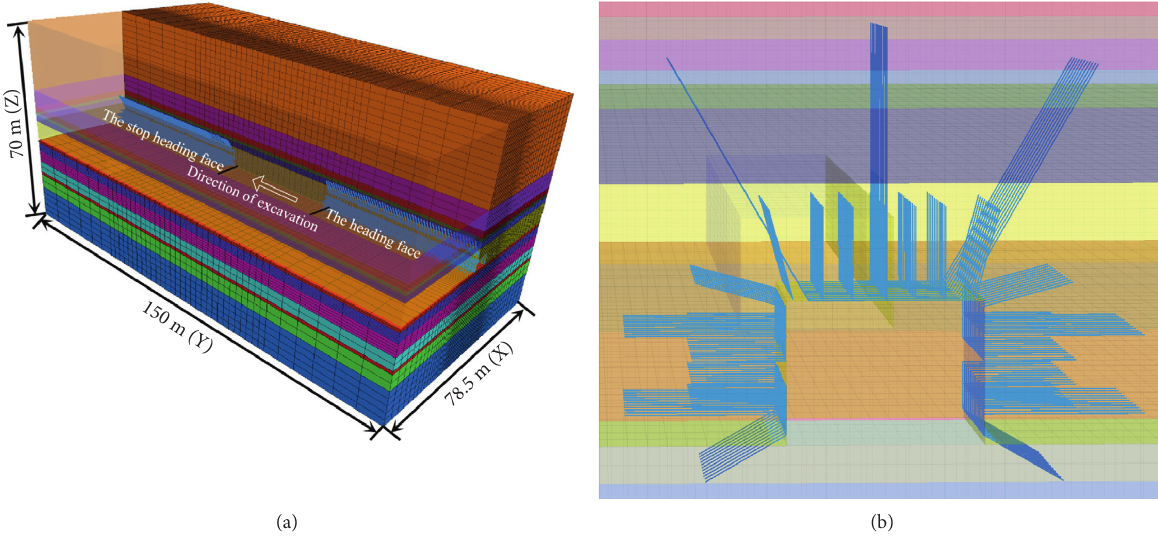
Figure 5: Numerical model. (a) Model size. (b) Roadway support. Table 1: Mechanical parameters of rock